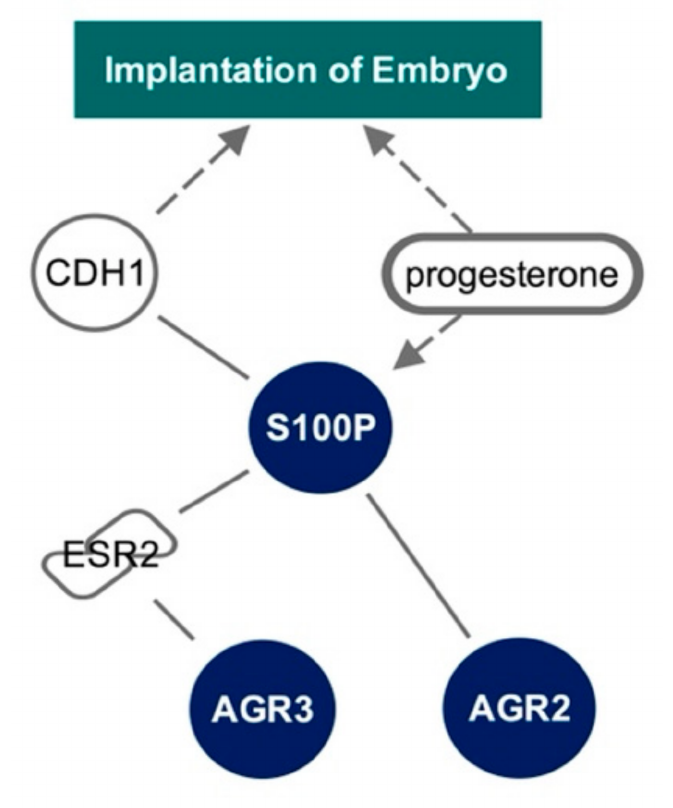
Figure 4. Pathway analysis to illustrate the relationship between S100P, AGR3, AGR2, and embryo implantation, using the Ingenuity Knowledge Base. Solid lines represent direct interactions. Dashed arrows represent indirect causation or